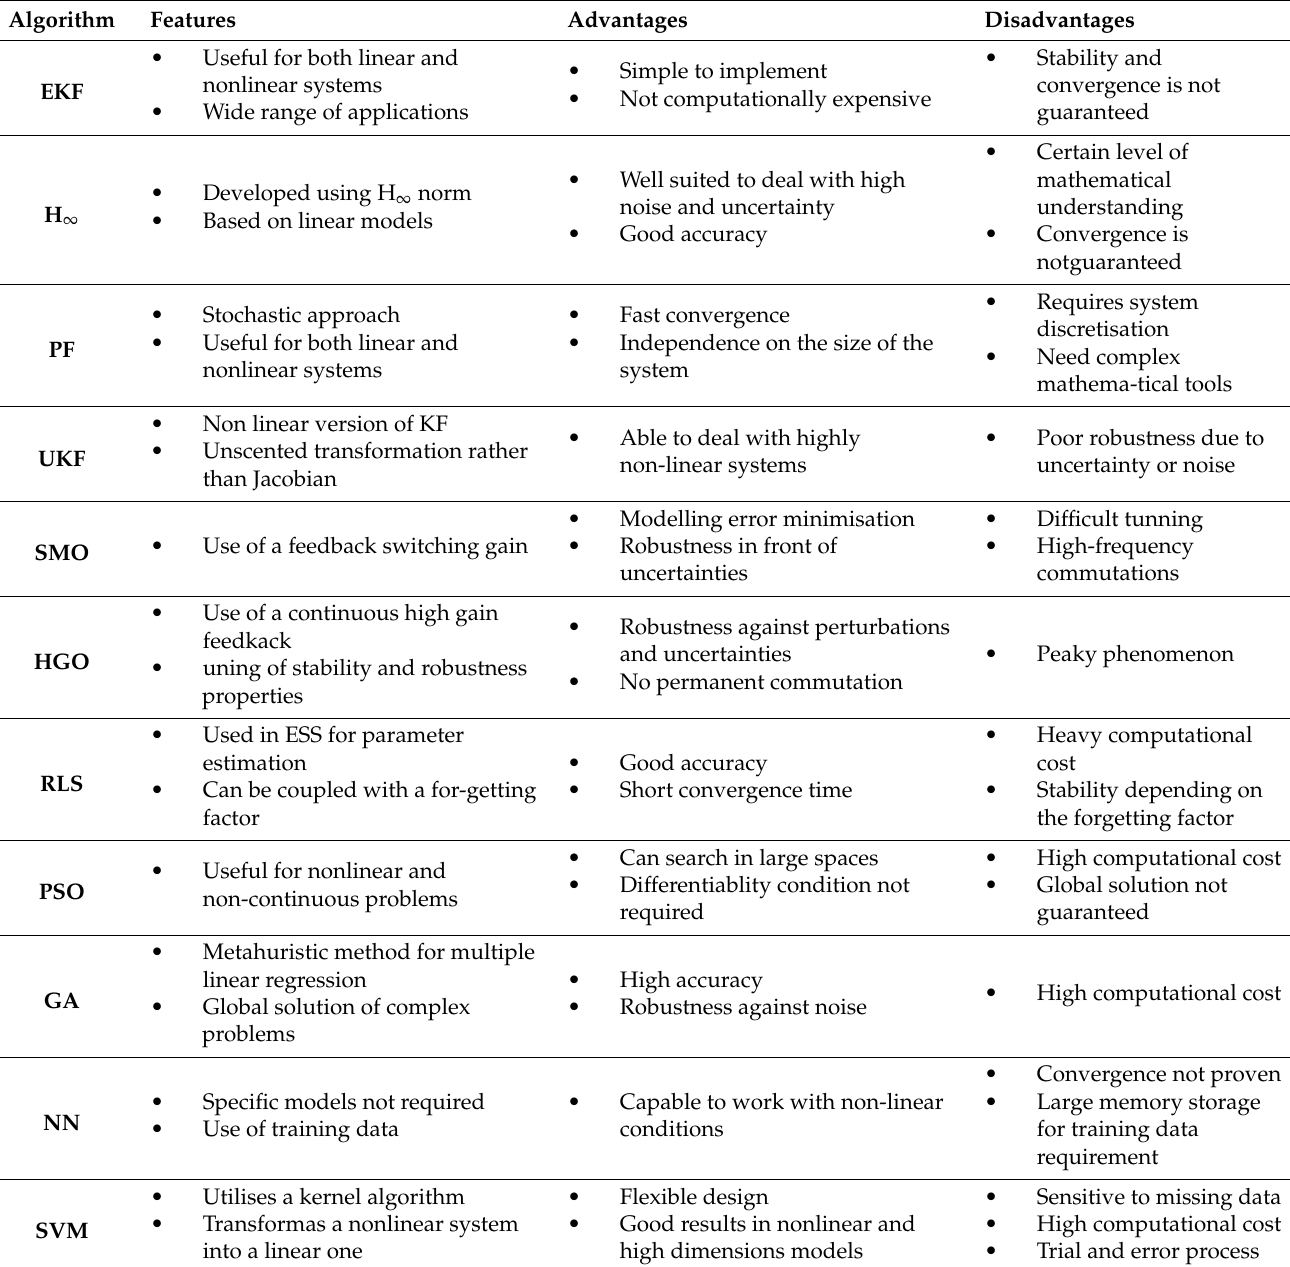
Table 3. Comparison of different state observers and parameter estimation